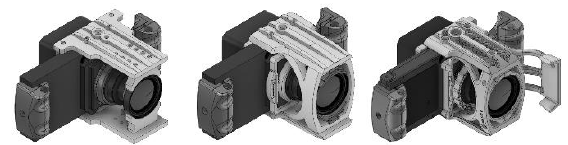
Figure 1. Development stages of the ALPA 12 FPS add|metric